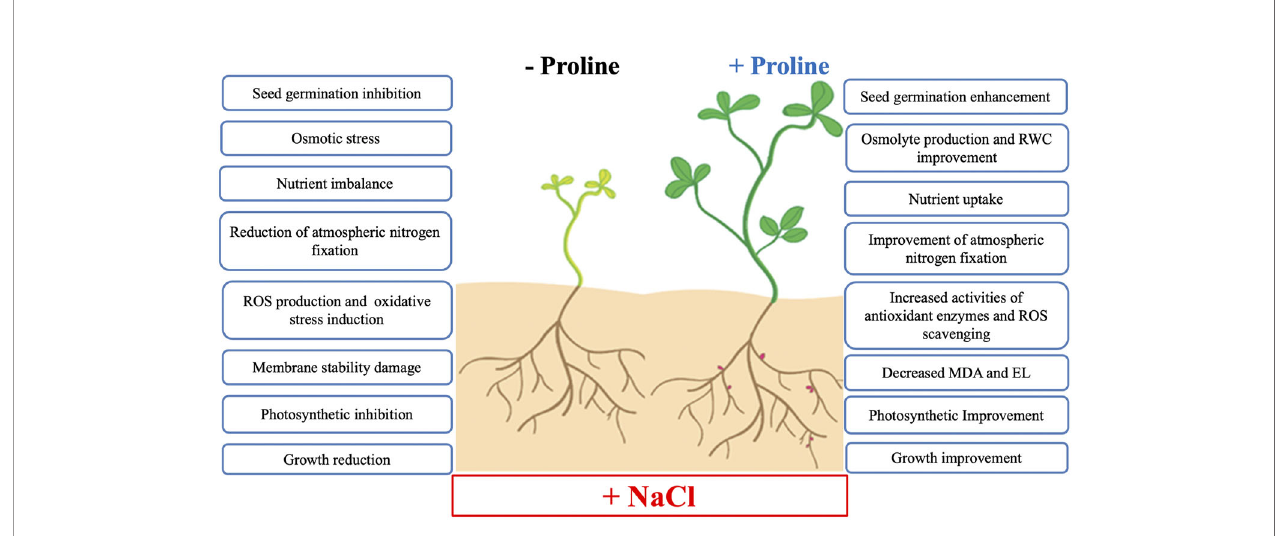
FIGURE 6 | Summary of the main effects of exogenous proline in plant salt tolerance. Abbreviations: RWC, relative water content; ROS, reactive oxygen species; MDA, malondialdehyde; EL, electrolyte